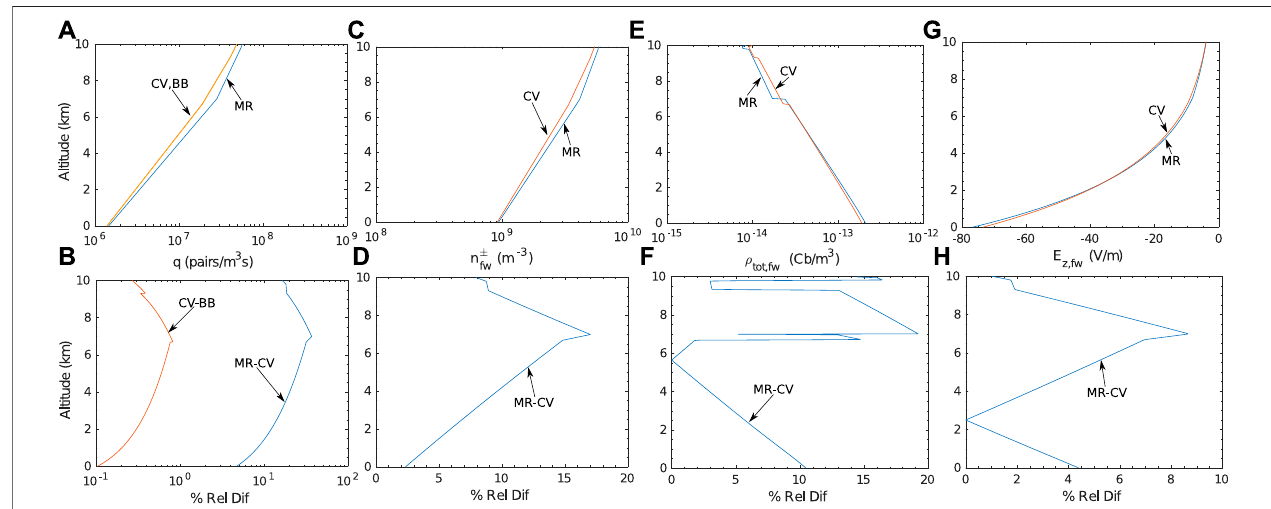
FIGURE 6 | Initial fair weather conditions in Mauritania (MR), Cape Verde (CV), and Barbados (BB): (A) ionization rates, (B) Relative difference between ionization rates, (C) fair weather ion densities, (D) relative difference between fair weather ion densities, (E) fair weather total charge densities, (F) relative difference between fair